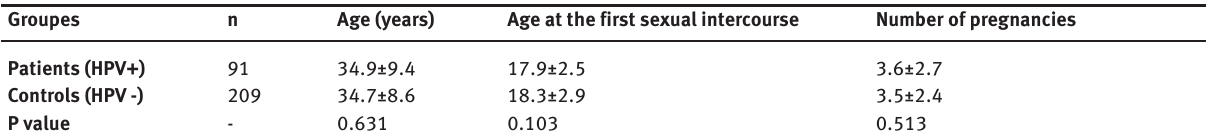
Table 1 : Demographic characteristics of cases and controls. Groupes